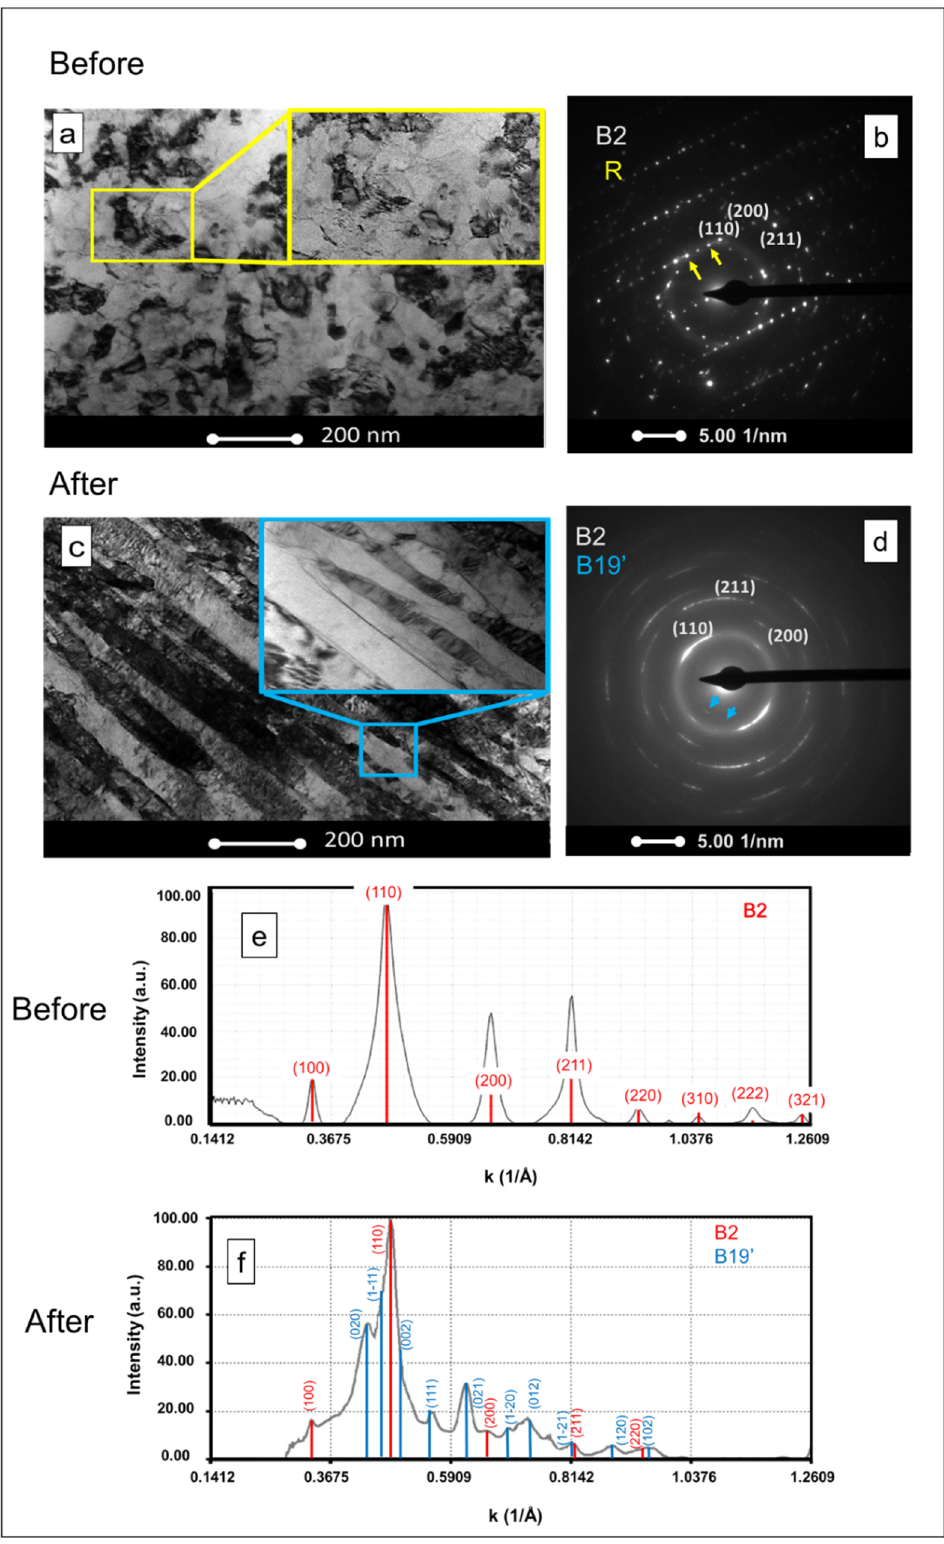
Figure 5. Microstructures of NiTi after and before low-cycle fatigue tests (TEM); ( a , c ) BF, ( b , d ) SAED patterns and ( e , f ) respective indexation.